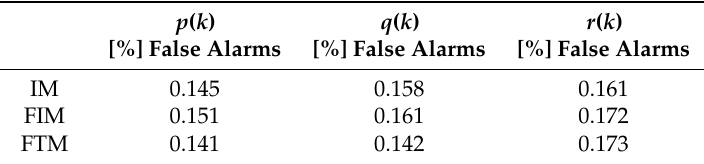
Table 9. Mean performance for the four validation flights in terms of % false